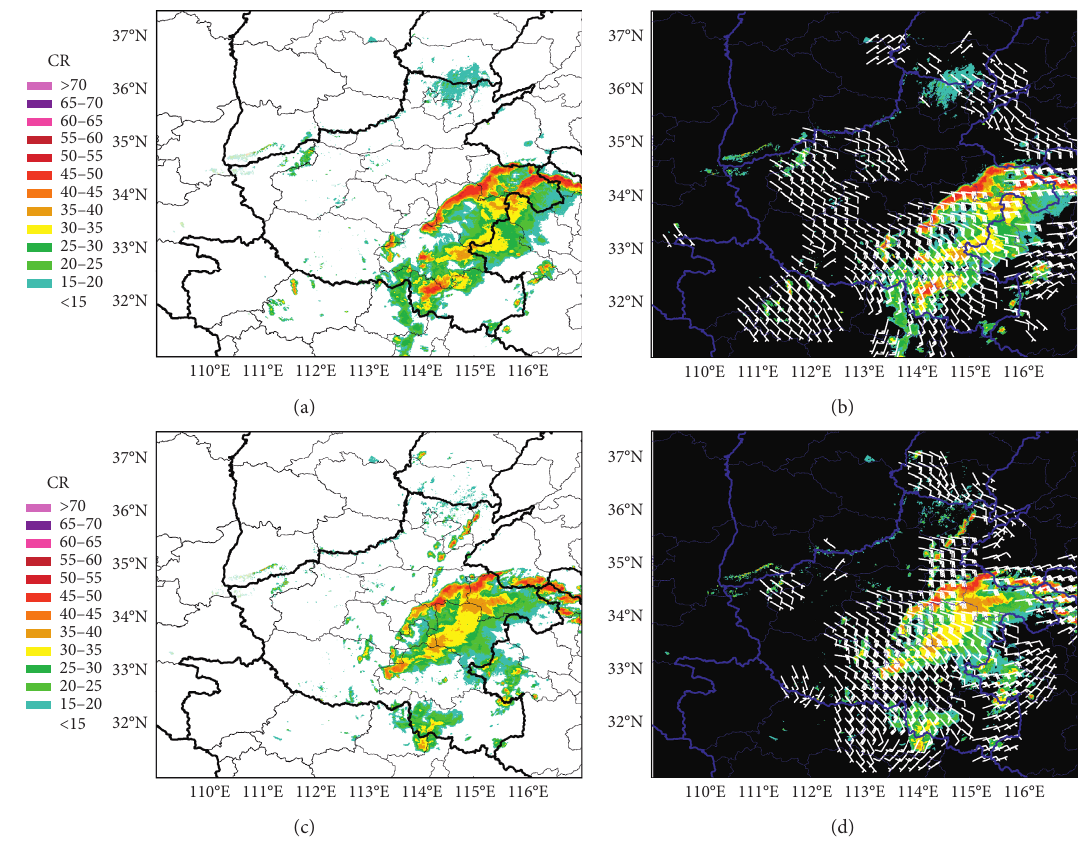
Figure 7: Evolutionary features of the composite reflectivity (a, c) and the wind field (b, d) at 0400UTC and 0554UTC August 1 2017. CR